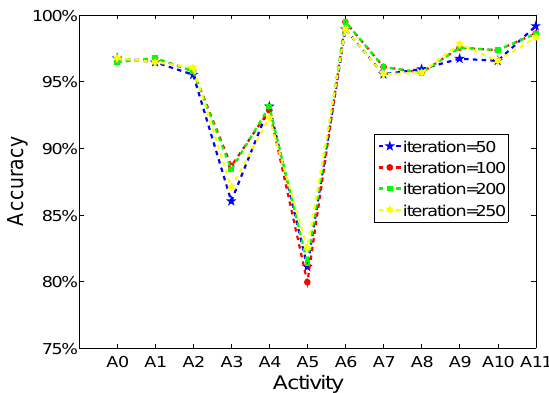
Figure 4. The recognition performance of each activity when using different iterations. (Pretraining learning rate is set to 1 × 10 − 7 , number of hidden layer is set to 2; fine-tuning learning rate is set to